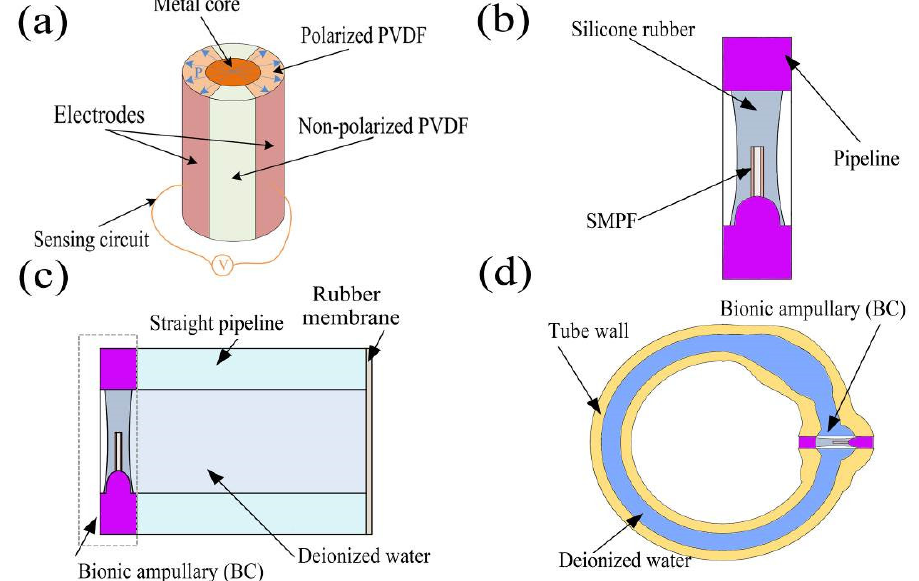
Figure 1. Diagrams of the structure of an ( a ) SMPF and circuit, ( b ) bionic ampulla (BA), ( c ) straight semicircular canal, and ( d ) one-dimensional bionic semicircular canal (1-BSC).